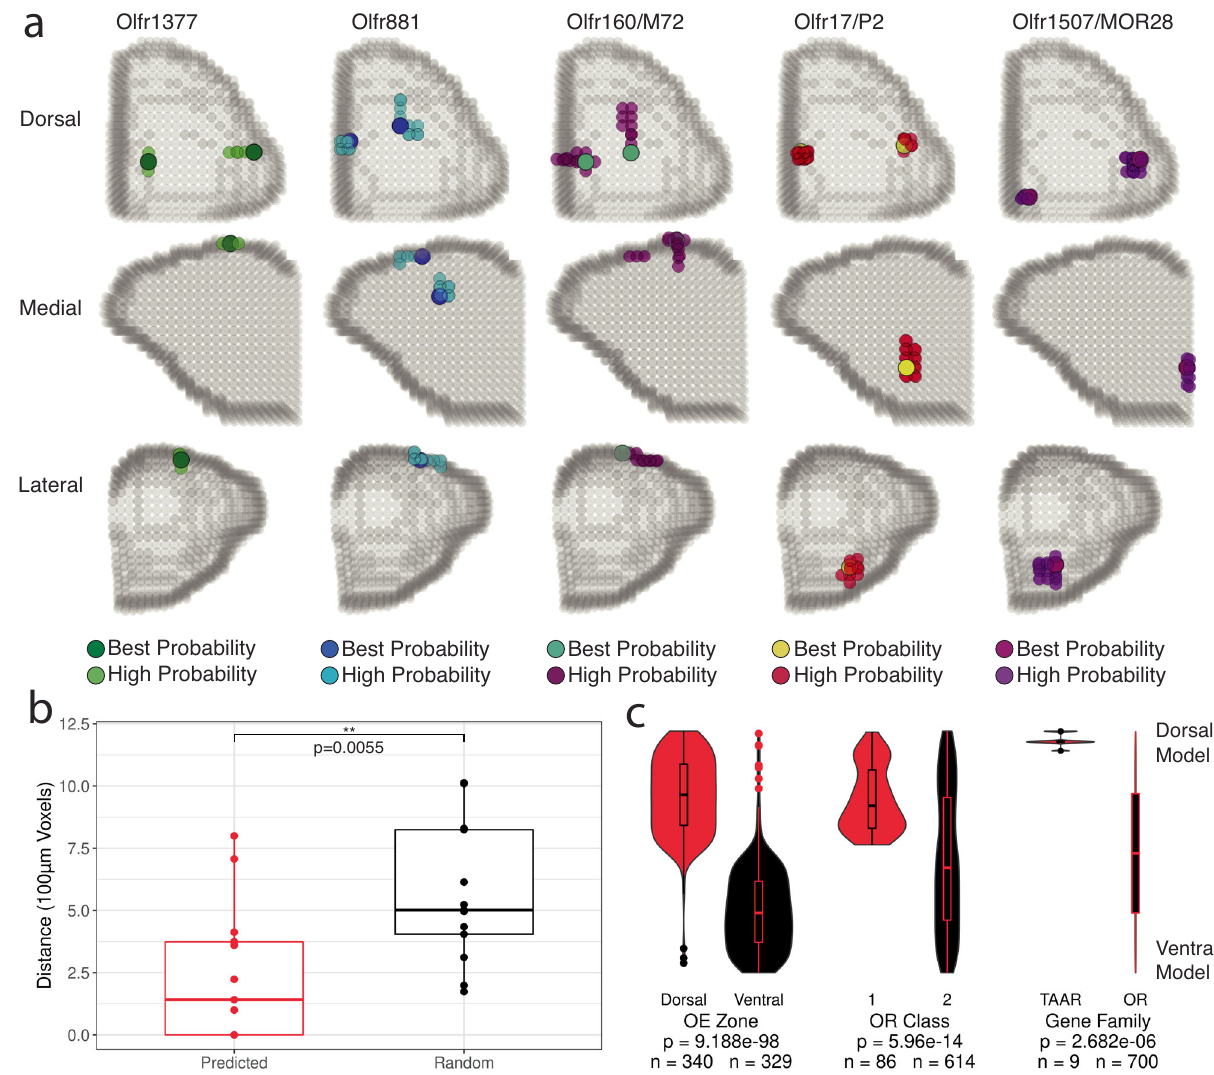
Fig.7|ModeledpositionsofglomeruliwithknownpositionsandORtranscript identity.a Three-dimensional assigned positions of glomeruli with labeled ORs generated in this study and from Zapiec and Mombaerts PNAS 2015.